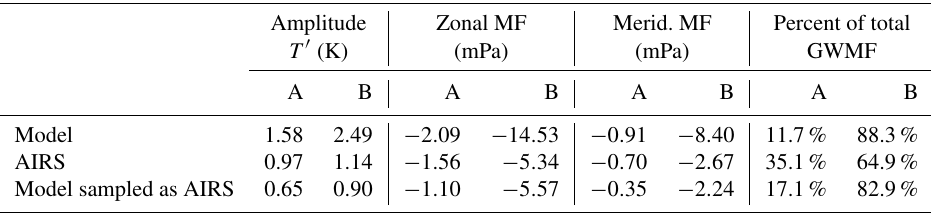
Table 1. Measured GW amplitudes and directional momentum fluxes in upwind (A) and downwind (B) regions of South Georgia in the full-resolution model, AIRS observations and the model sampled as AIRS. Values are averaged between 25 and 45km altitude over regions A and B (see Fig. 4) for all GW measurements during July 2013 and June–July 2015. The two rightmost columns show the fractions of total absolute GWMF in region C that were measured in regions A and B. Note that GWMF in the full-resolution model is calculated using Eq. (1), but AIRS and the model sampled as AIRS GWMF is calculated via Eq. (2).